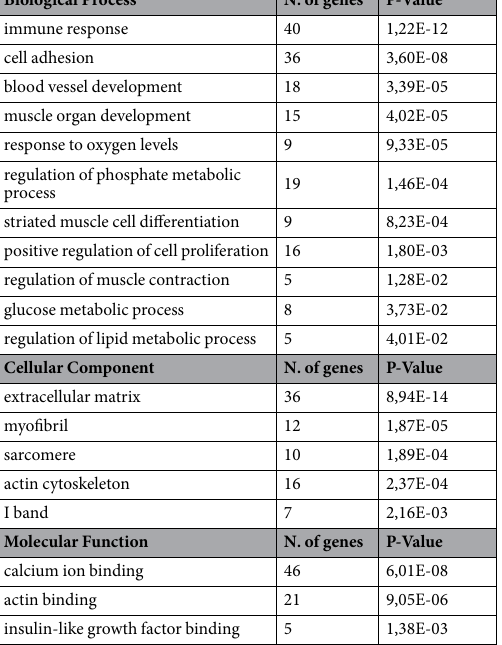
Table 1. Gene Ontology analysis of genes upregulated in cyclin D3 − / − muscle. Gene Ontology analysis for biological processes, cellular component and molecular function of genes upregulated by ≥ 1,45-fold in muscles of D3 − / − mice versus WT mice. Terms with at least 5 genes associated genome-wide and an enrichment P-Value < 0,05 were evaluated. Additional information in Supplementary Table